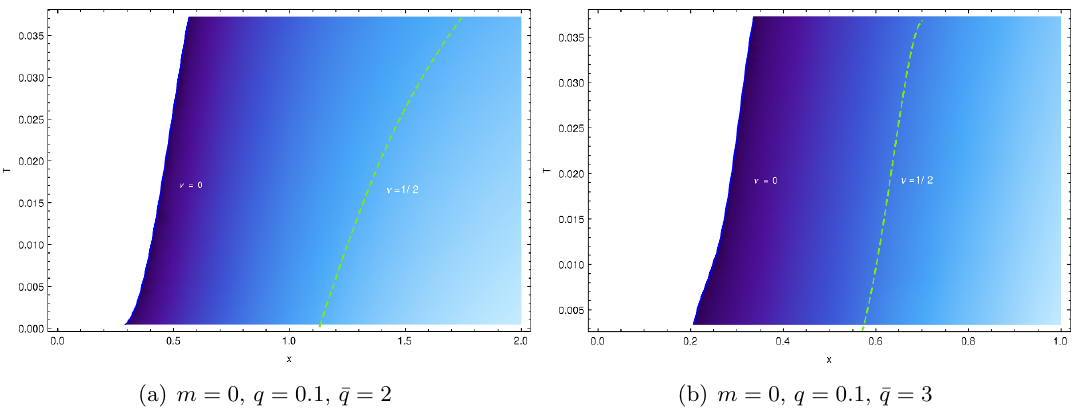
Figure 2 . The T vs. x plane, shaded according to the values of (cid:23) k . Darker regions correspond to F smaller (cid:23) k , while lighter regions correspond to larger values. In the white regions (cid:23) k is complex. F F The dashed green line depict the value (cid:23) k = 1 = 2, at the right of which stable quasiparticles F exist. Notice that the line is tilted to the right, implying that the critical value of x increases with temperature. Both plots correspond to vanishing probe mass m = 0; notice that, in agreement with the T = 0 plots, there is no region in the plane in which the value (cid:23) k = 1 is F